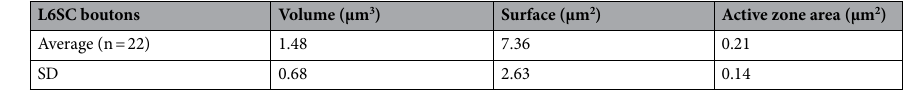
Table 3. 3D-parameters of L6SC boutons. Note that the data is corrected for tissue shrinkage.